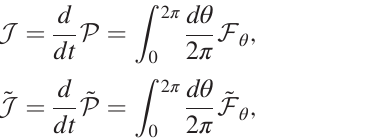
¯ P 0 in Eq. (14), and the change of